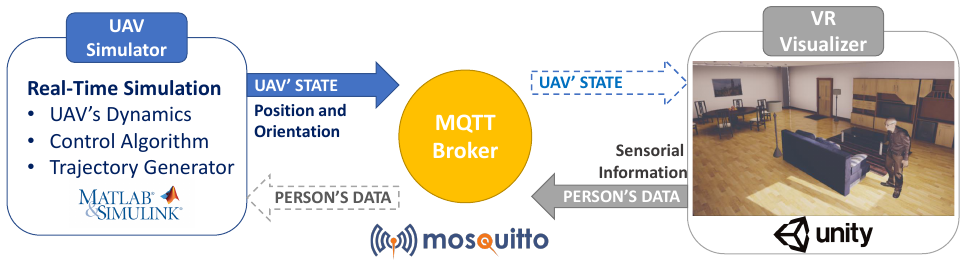
Figure 8. Architecture of the distributed